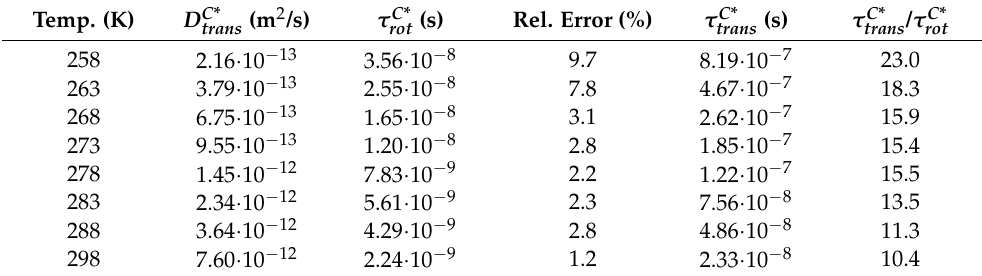
Table 3. Parameters characterising the translational and rotational dynamics of TEA-C4 cations in [TEA-C4][TFSI] including the R inter , HF 1, F